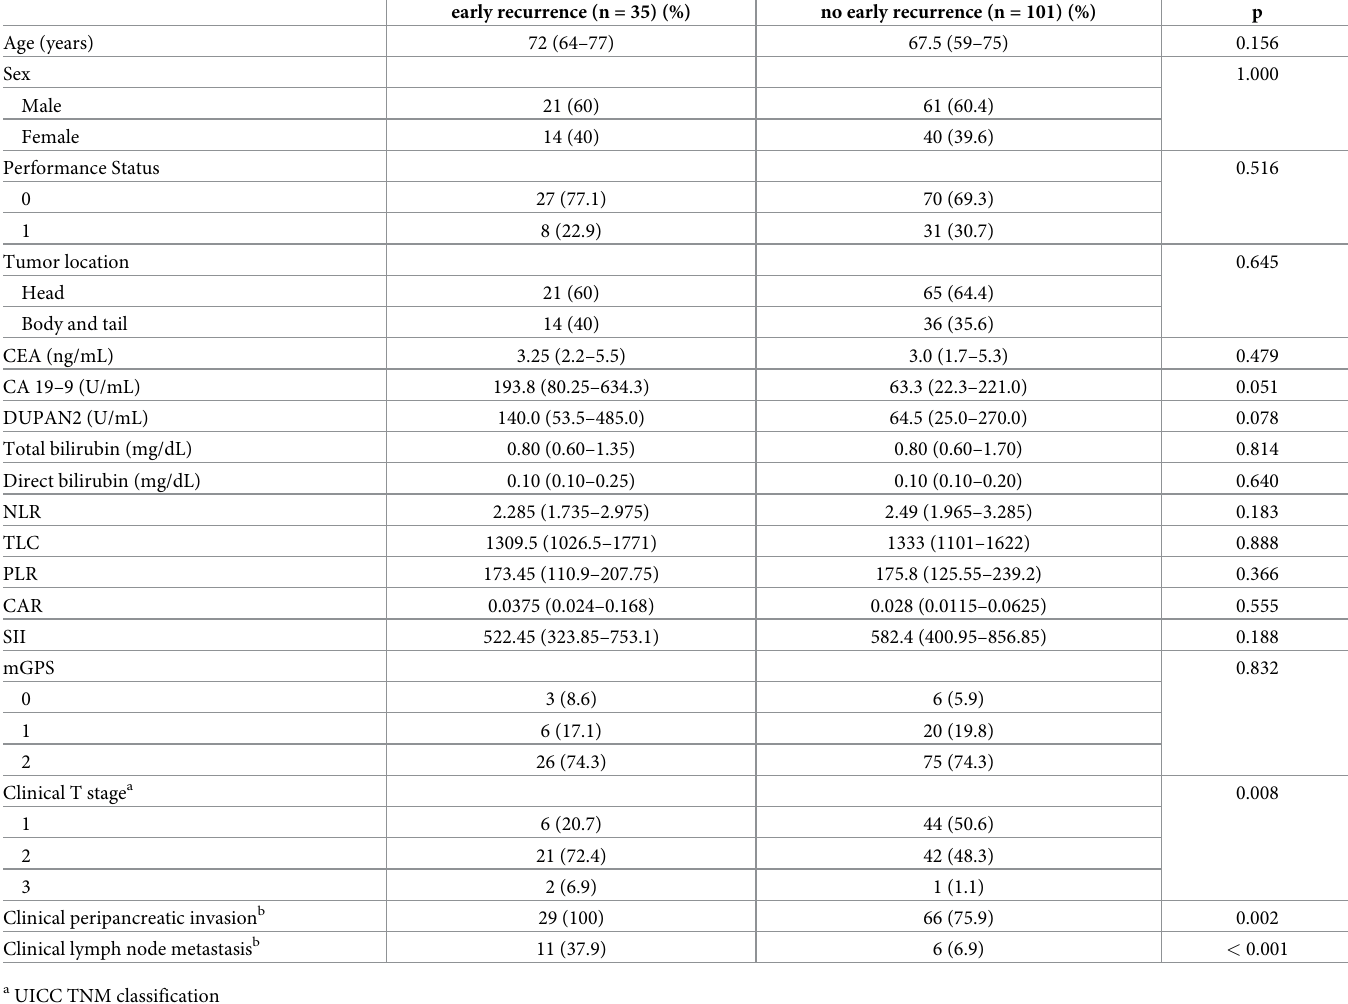
Table 1. Baseline clinicopathological characteristics of patients who did or did not suffer early recurrence.